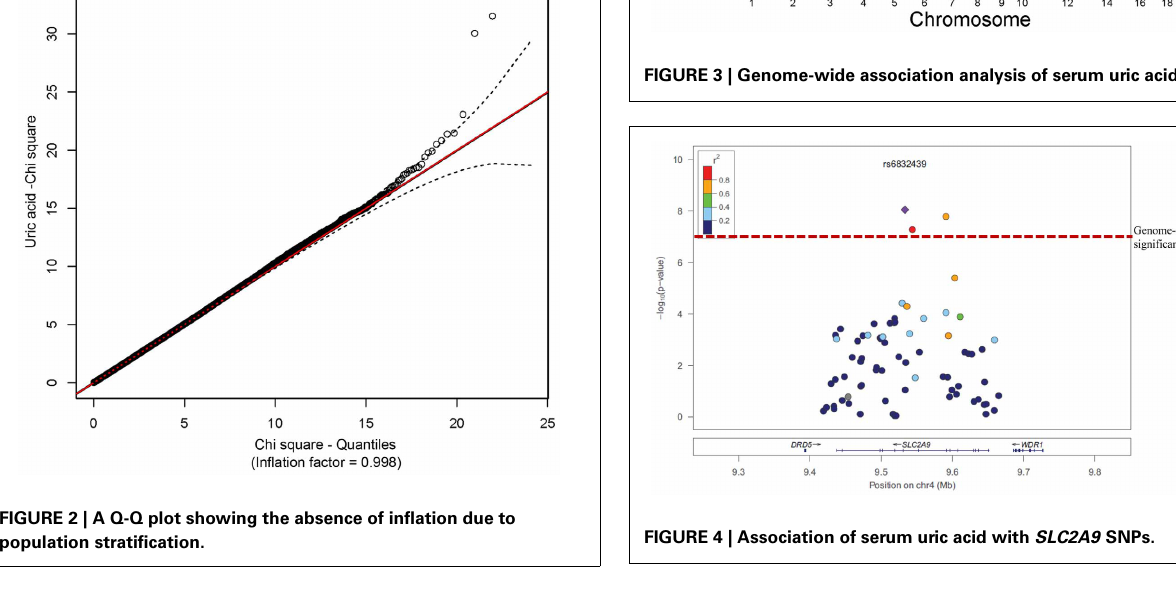
Table 1 | Joint linkage-association analysis of serum uric acid (Empirical genome-wide significance: p < 1 . 3 × 10 − 7 ).